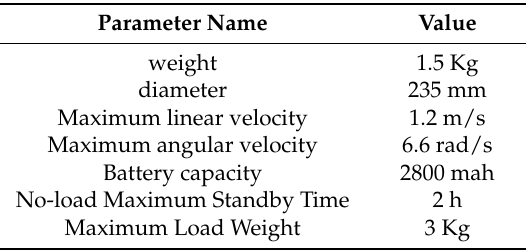
Table 1. Omnidirectional robot parameters.